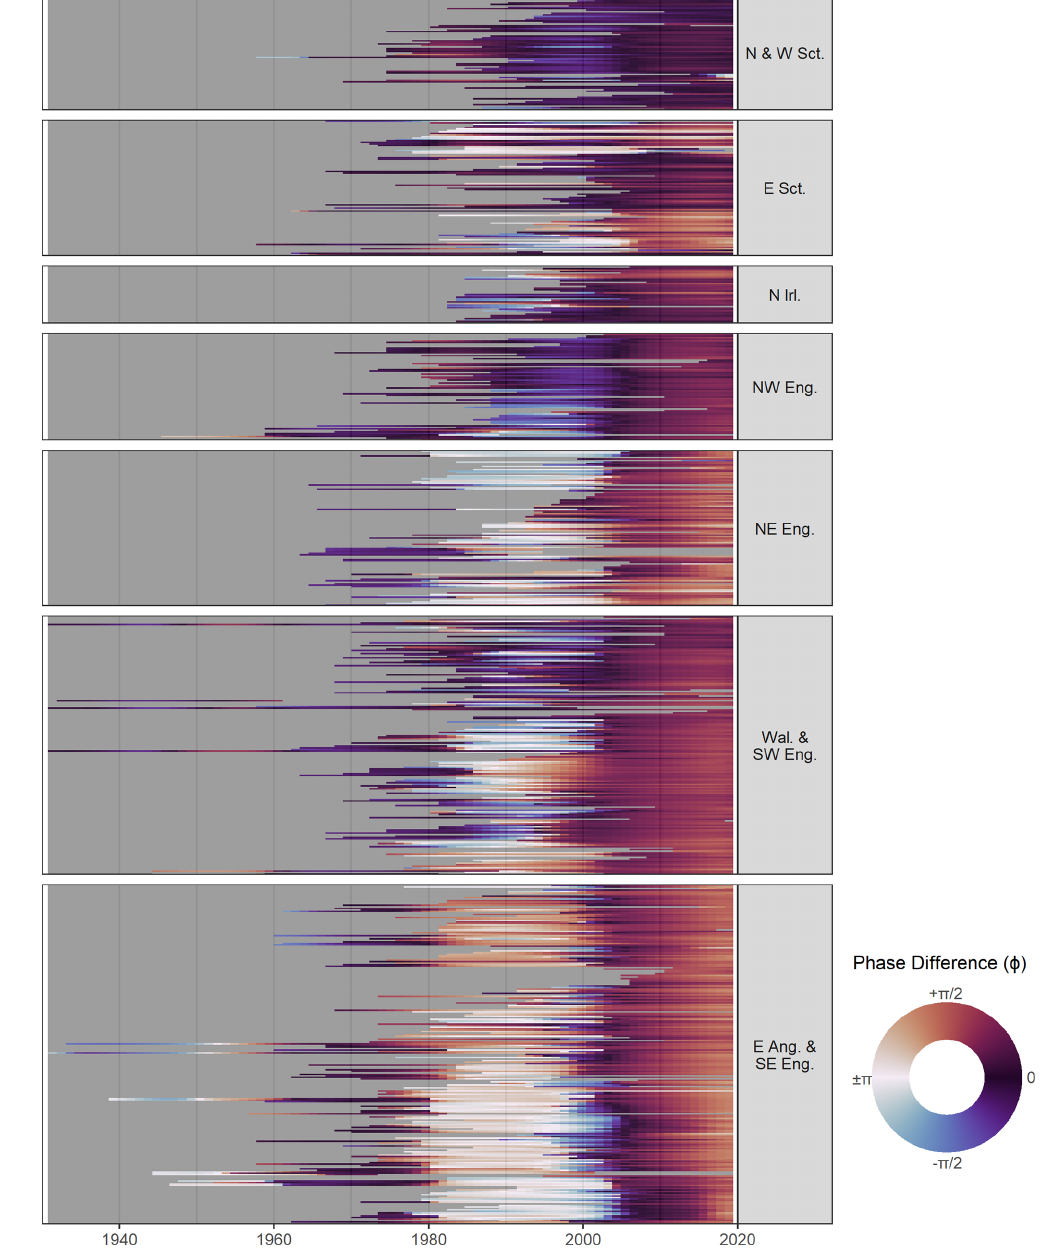
Figure 5. Phase difference between the NAOI and each streamflow record for the streamflow record period. Results are grouped by regions. φ = 0 is equivalent to an in-phase relationship and φ = ± π is equivalent to an anti-phase relationship.